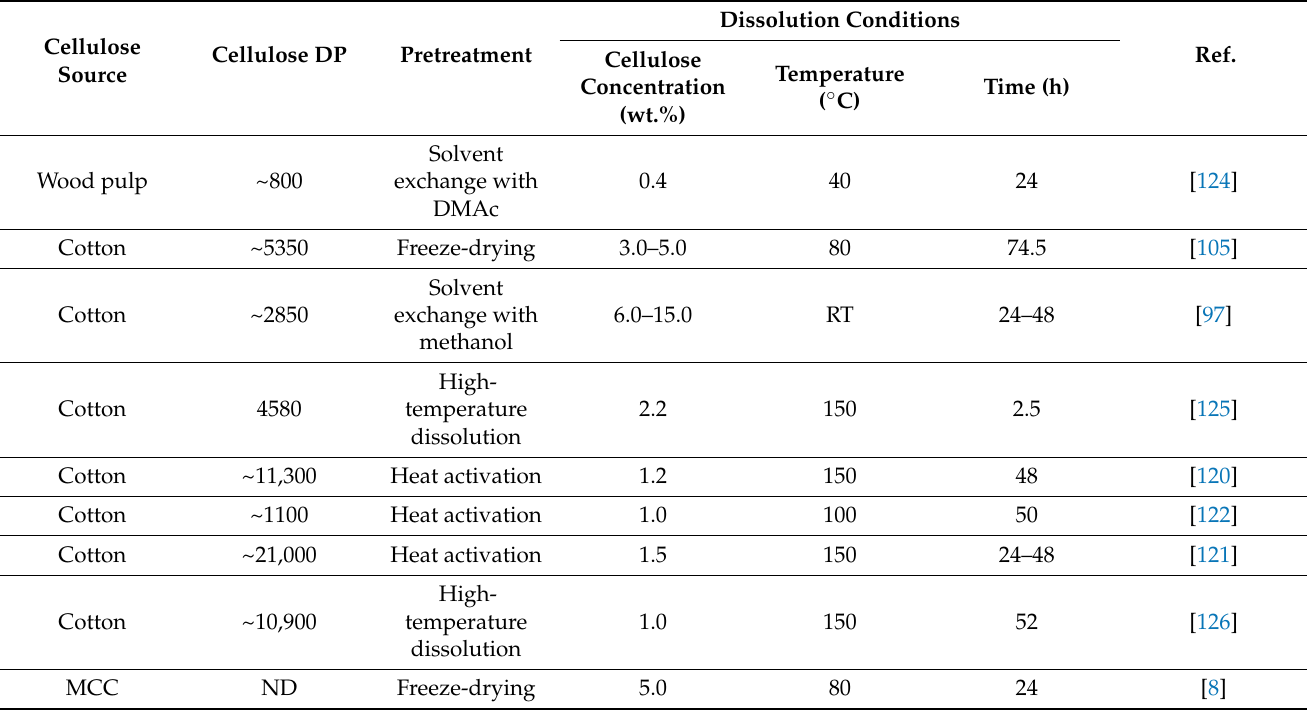
Table 2. Representative examples of cellulose dissolution in DMAc/LiCl, including pretreatment strategies or high- temperature